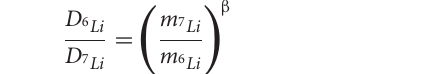
Frontiers in Earth Science |